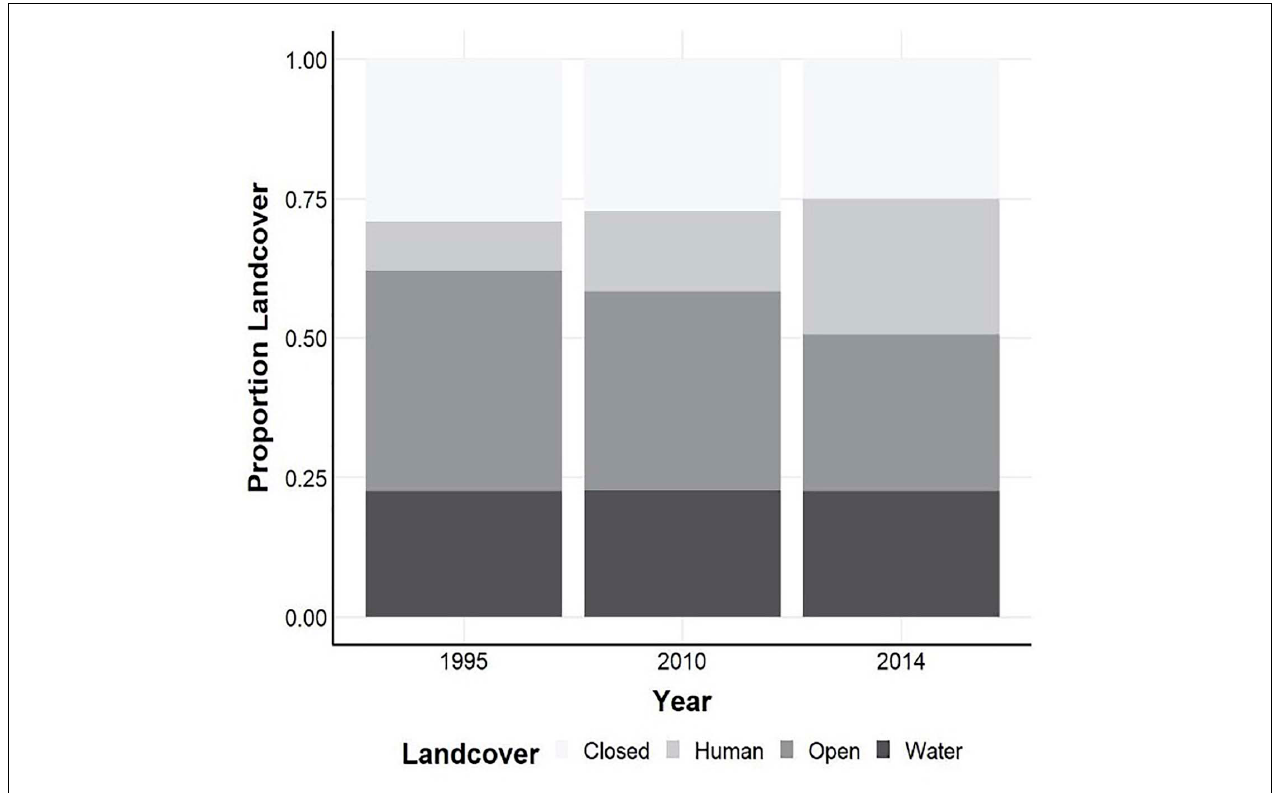
FIGURE 4 | Estimates of landcover for classifications of 1995, 2010, and 2014.